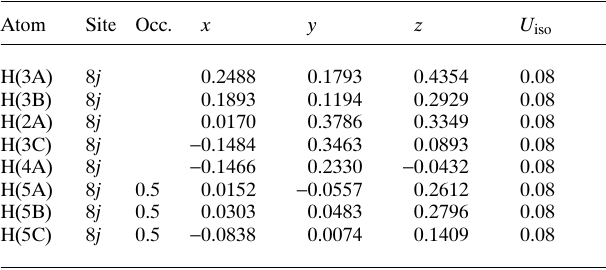
Table 2. Atomic coordinates and displacement parameters (in Å 2 )